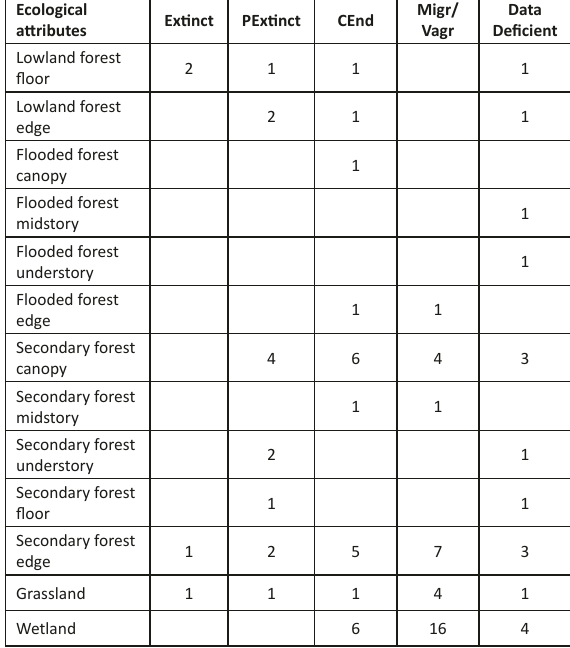
Migr/ Data Vagr Deficient